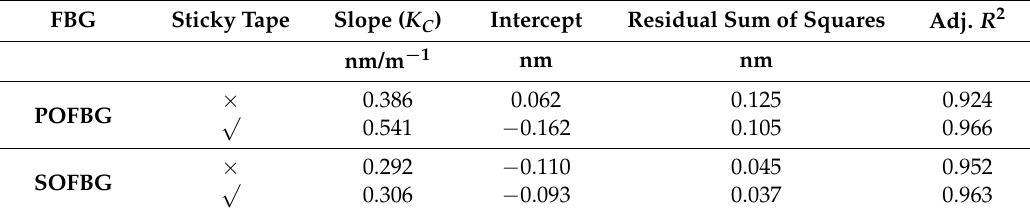
Figure 4. Bend response of POFBG ( a ) and SOFBG ( b ) on the upper surface of brass beam without and with sticky tape fixing vs. the curvature, when the beam is bent upwards. Table 3. The linear fitting results of POFBG and SOFBG response to the bend with and without sticky tape